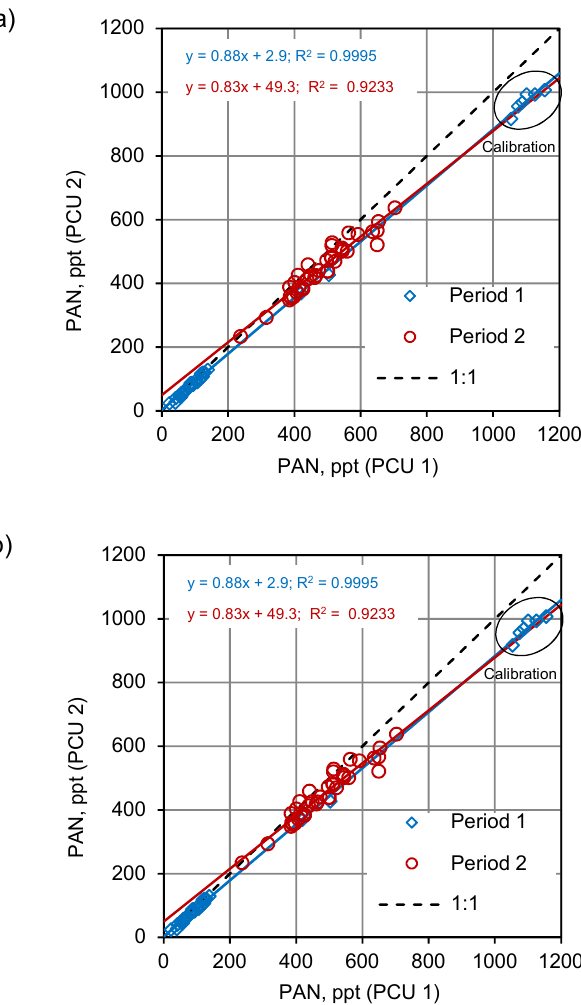
Figure 6. Results from side-by-side measurements for two periods Figure 6: Results from side-by-side measurements for two periods during (a) HREA operation after 1 during (a) HREA operation after correction for pressure effects (see Sect. SM4 in the Supplement) and (b) MBR operation of the PAN correction for pressure effects (see SM 4) and (b) MBR operation of the PAN flux measurement 2 flux measurement system. For the conversion to PAN mixing ratios, the calibration coefficient from PCU 1 was applied for both PCU 1 system, respectively. For the conversion to PAN mixing ratios, the calibration coefficient from PCU#1 3 and PCU 2 to illustrate the systematic deviation from the 1 : 1 was applied for both PCU#1 and PCU#2 to illustrate the systematic deviation from the 1:1 slope. 4